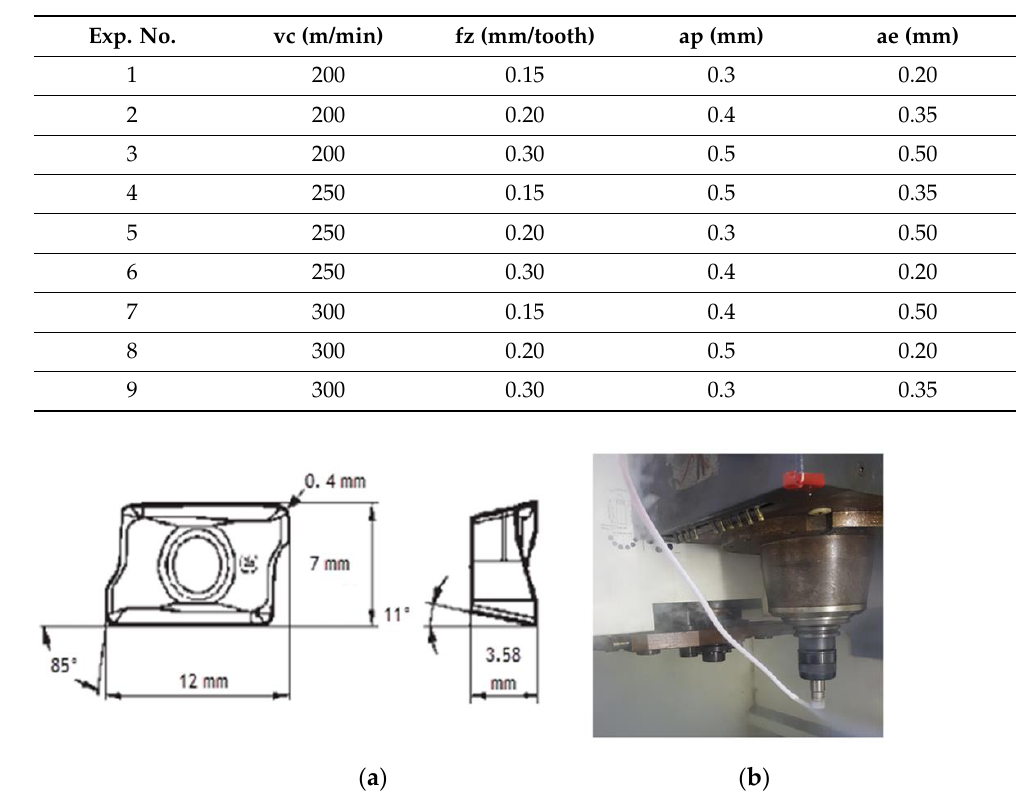
Table 4. Taguchi Method L9 Orthogonal Array design of experiments.